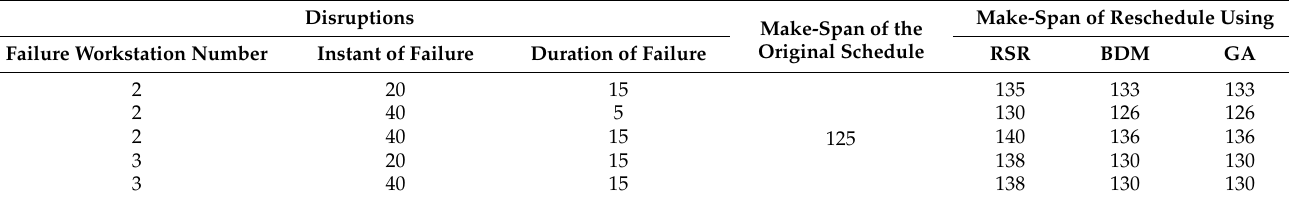
Table 5. Make-span obtained by rescheduling.